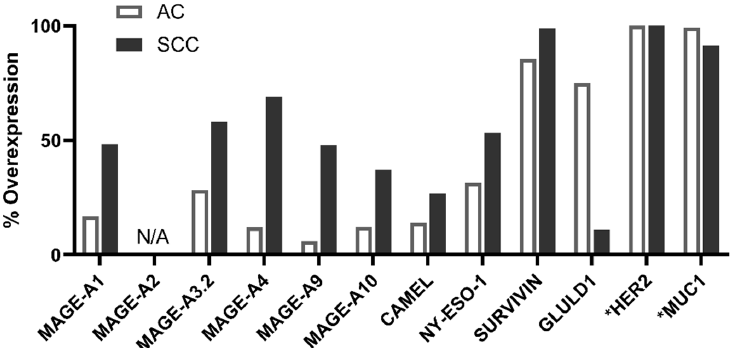
Figure 1. mRNA overexpression frequency of selected antigens in NSCLC subtypes. Gene overex- pression frequencies in tumoral versus non-tumoral lung samples were calculated after the analysis of the TCGA data set, except for GLULD1 and NY-ESO-1; the frequencies of which were calculated using the GSE30219 data series. *For HER2 and MUC1 genes, the percentage of expression—and not overexpression—frequency is shown because their mRNAs are ubiquitously expressed in normal tissues. A threshold corresponding to the signal in fetal tissues which do not express the two cell carcinoma.